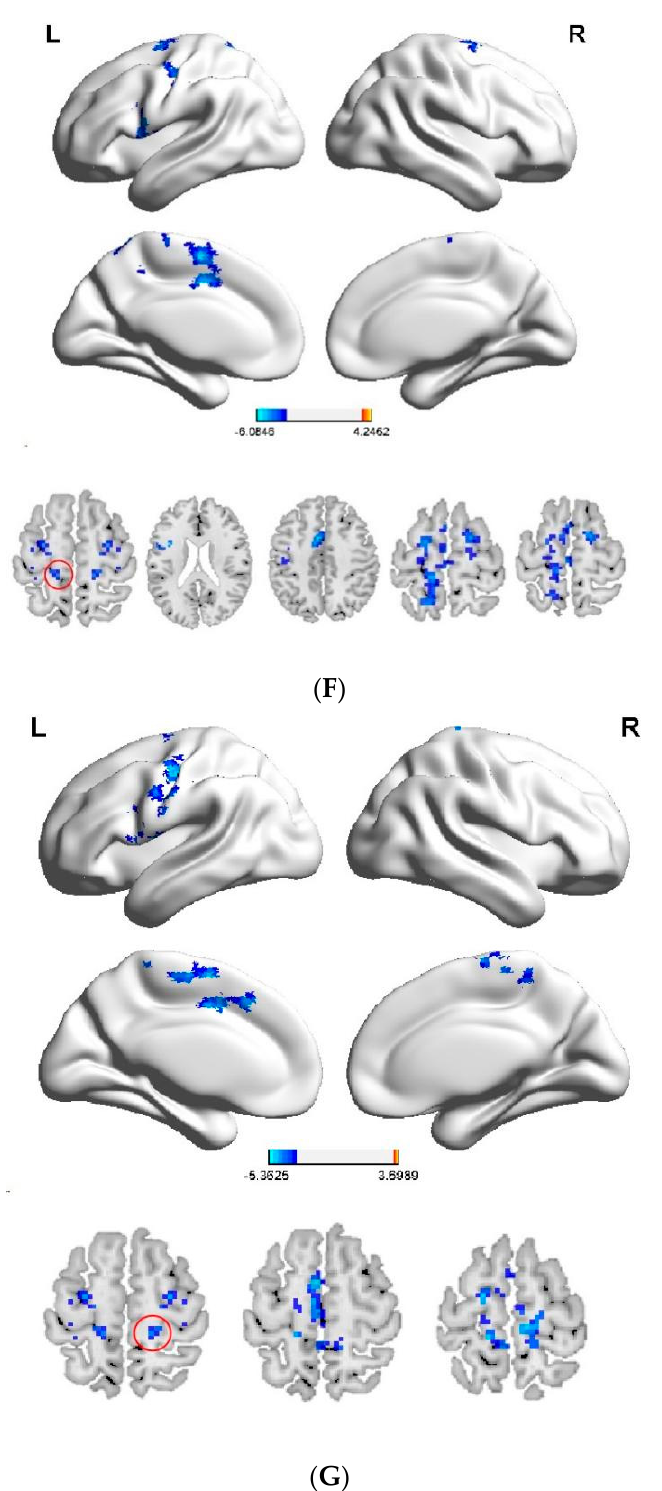
Figure 3. ( A – G ) Differences in seed-based FC between female MwoA patients and HCs. Red circles indicate seed regions. Blue colors represent decreased FC values. Relative to the HCs, patients exhibited decreased FC ( A ) between the right cerebellum_8 and both the right inferior temporal gyrus and left paracentral lobule; ( B ) between the left lingual gyrus and the left fusiform gyrus, left calcarine cortex, and left cuneus; ( C ) between the right cuneus and left superior occipital gyrus; ( D ) between the right precentral gyrus and both the left inferior parietal lobule and left superior frontal gyrus; ( E ) between the left precentral gyrus and the left postcentral gyrus, left supplementary motor area, and left paracentral lobule; ( F ) between the right postcentral gyrus and the left opercular part of inferior frontal gyrus, left median cingulate and paracingulate gyrus, left paracentral lobule, and right superior frontal gyrus; and ( G ) between the left postcentral gyrus and both the left supple- mentary motor area and left paracentral lobule. Abbreviations: FC, functional connectivity; MwoA, migraine without aura; HCs, healthy controls.